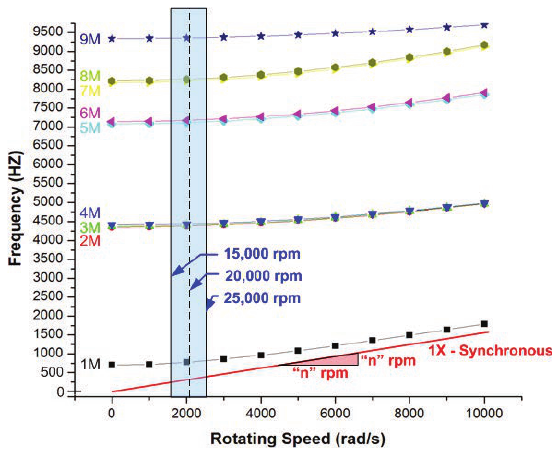
Fig.13. Campbell diagram of 8A impeller Figure 13. Campbell diagram of 8A impeller.